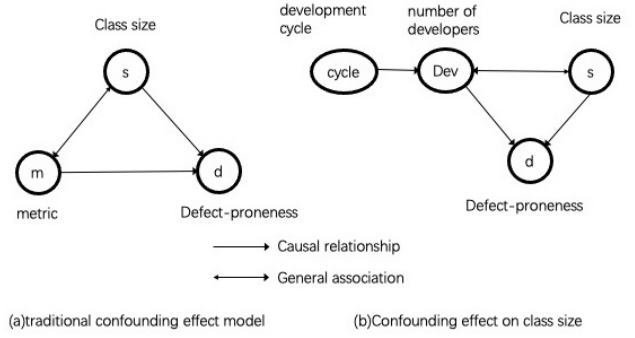
Figure 1. Confounding effect model in software defect